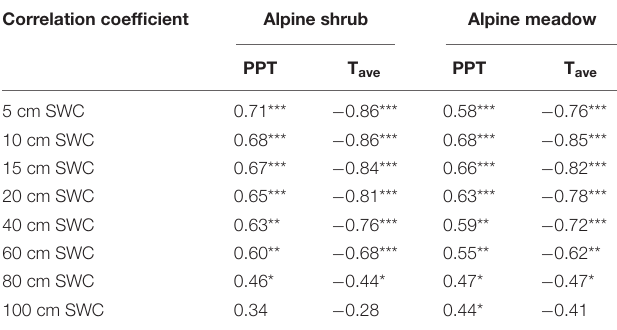
TABLE 2 | Pearson’s correlation between precipitation and soil moisture at different soil layers for alpine shrub and alpine meadow. Correlation coefficient Alpine